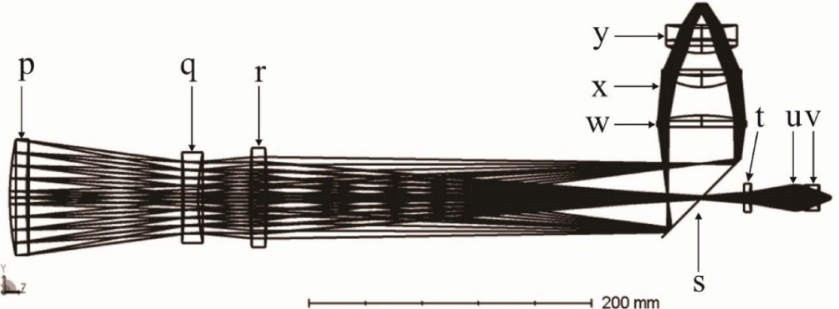
Figure 7. The receiving optical system, where p represents the objective group first lens, q depicts the objective group second lens, r indicates the objective group third lens, s denotes the split-field lens, t refers to the first lens of the APD eyepiece group, u represents the second lens of the APD eyepiece group, v signifies the first lens of the APD eyepiece group, w represents the first lens of the PMT eyepiece group, x represents the second lens of the PMT eyepiece group, and y represents the first lens of the PMT eyepiece